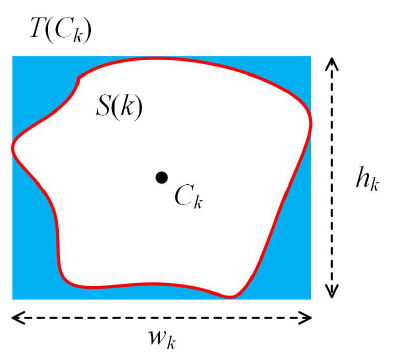
Figure 3. Determination of the window size and location of